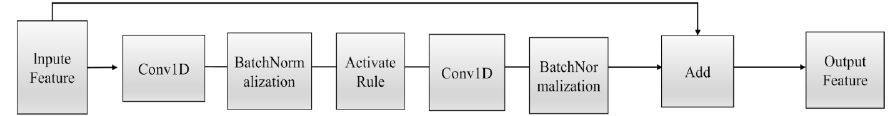
into the 1D convolutional network with the residual structures, as illustrated in Figure 6.